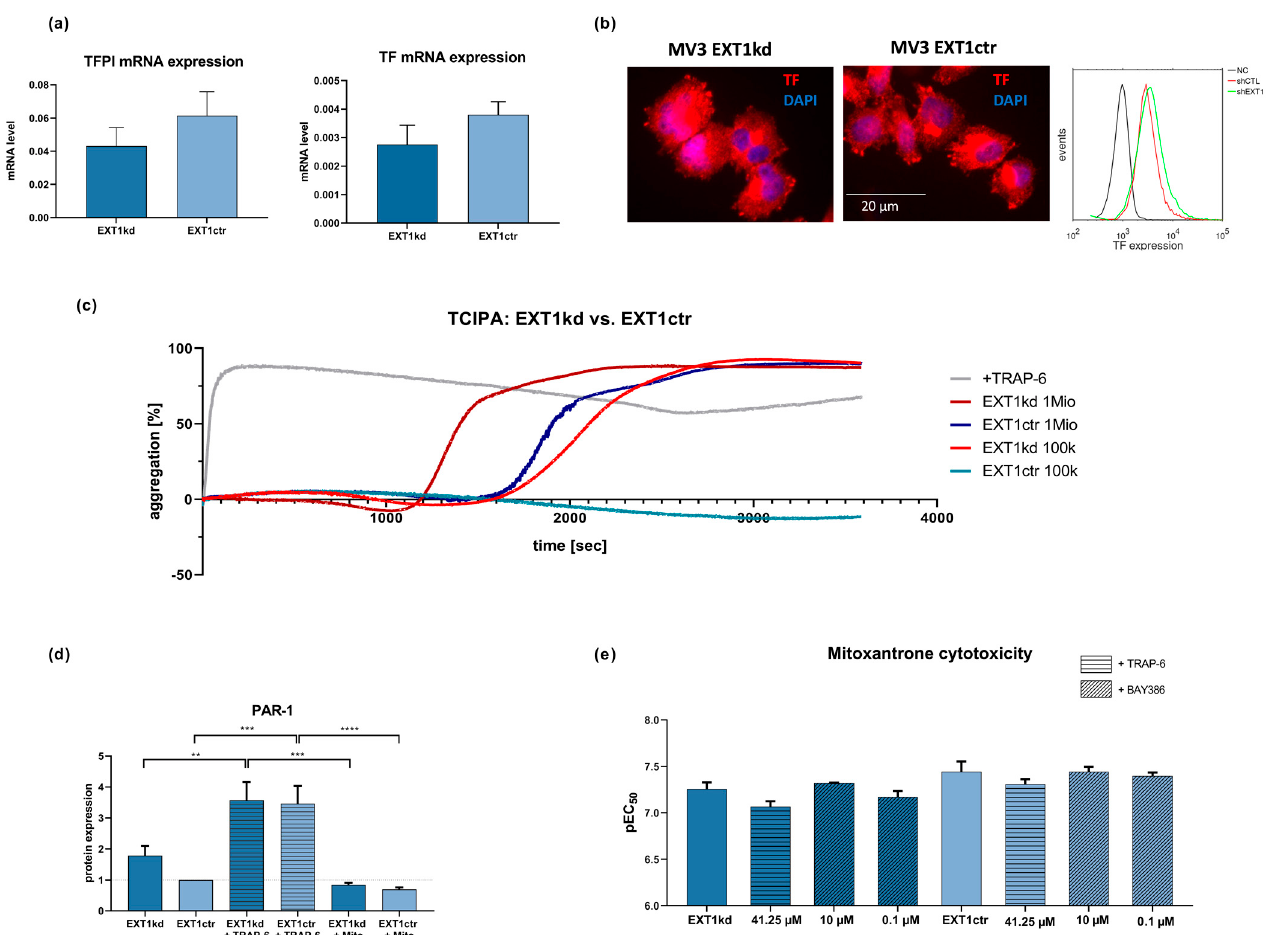
Figure 3. ( a ) qPCR data of TF and TFPI in MV3 EXT1kd and MV3 EXT1ctr cells. Data indicate that transcriptional expression of TF was very low and appeared not to be significantly affected, while TFPI mRNA levels were downregulated in MV3 EXT1kd cells. ( b ) Fluorescence microscopy images of immune stained MV3 cells indicated reasonable protein levels of TF. Moreover, flow cytometric detection of TF expression of MV3 EXT1kd and MV3 EXT1ctr cells indicated comparably more TF on the surface of MV3 EXT1kd cells. ( c ) Detection of platelet aggregation induced by MV3 EXT1kd and MV3 EXT1ctr cells was given by light transmission aggregometry, using two different cell counts. Data, representative curves of at least n = 3, confirmed that EXT1 kd led to a more rapid platelet activation compared to control cells. ( d ) Detection of PAR-1 expression on MV3 EXT1kd and MV3 EXT1ctr cells by Western blot refers to higher PAR-1 levels in the EXT1 knockdown cells. ( e ) Impact of activating or antagonizing PAR-1 in MV3 EXT1kd and MV3 EXT1ctr cells on sensitivity to mitoxantrone cytotoxicity. ( a , d , e ) Data represented as mean ± SD ( d , e ). For statistics, an ANOVA was performed (** = p < 0.01, *** = p < 0.001, **** = p < 0.0001).